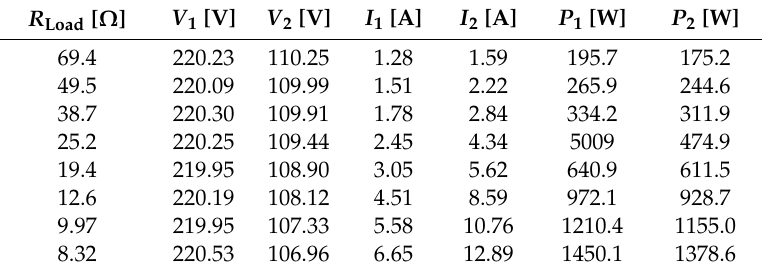
Table 8. Experimental results—Load data.